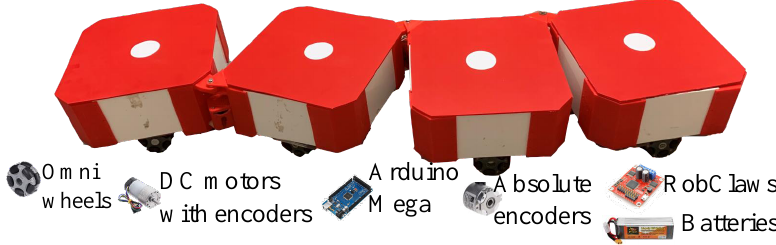
Figure 2. Hardware platform.